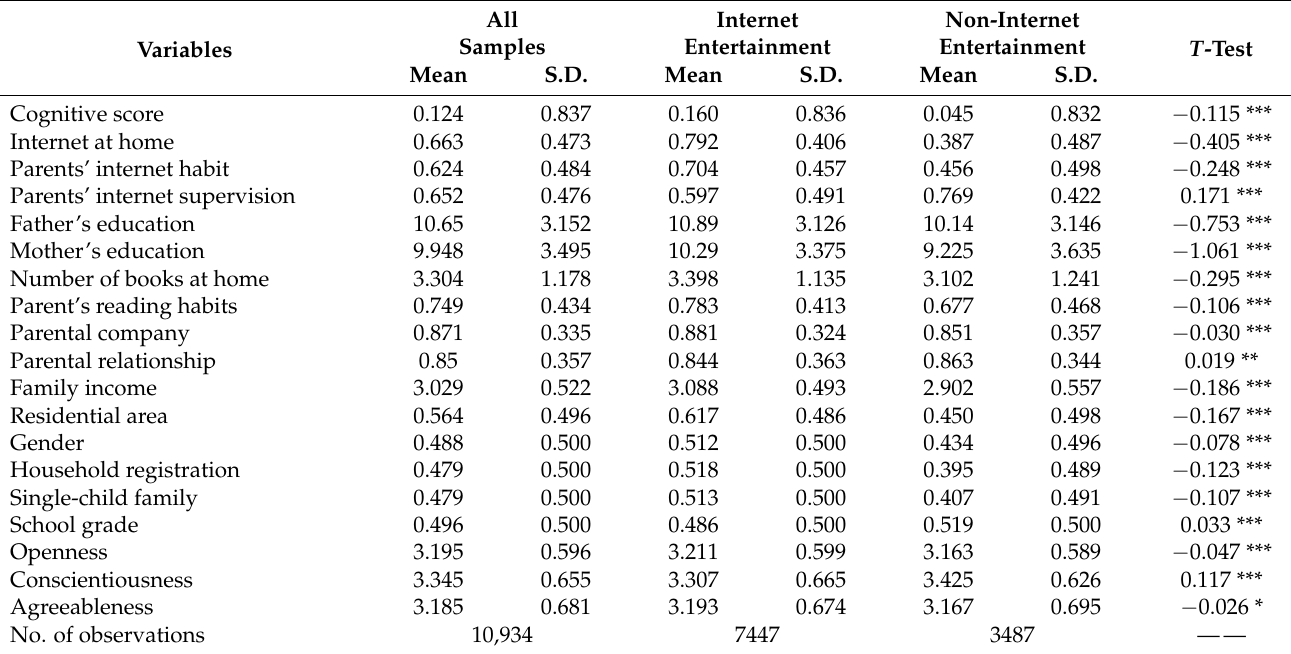
Table 1. Descriptive